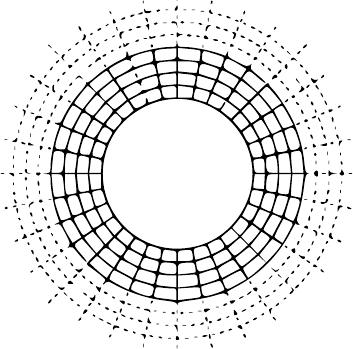
Figure 2. The network of lattice sites around a